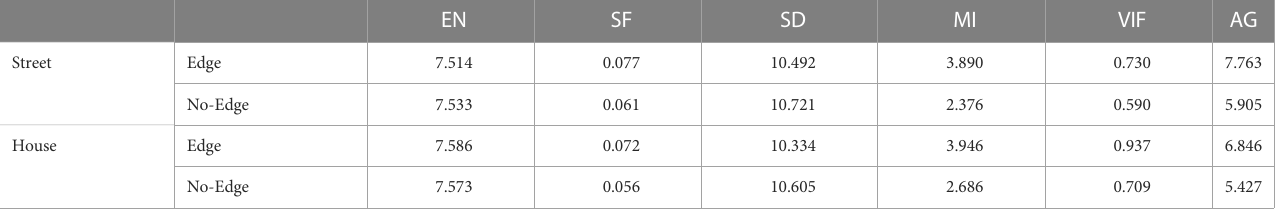
TABLE 1 The quantitative results on the four images shown in Figure 10